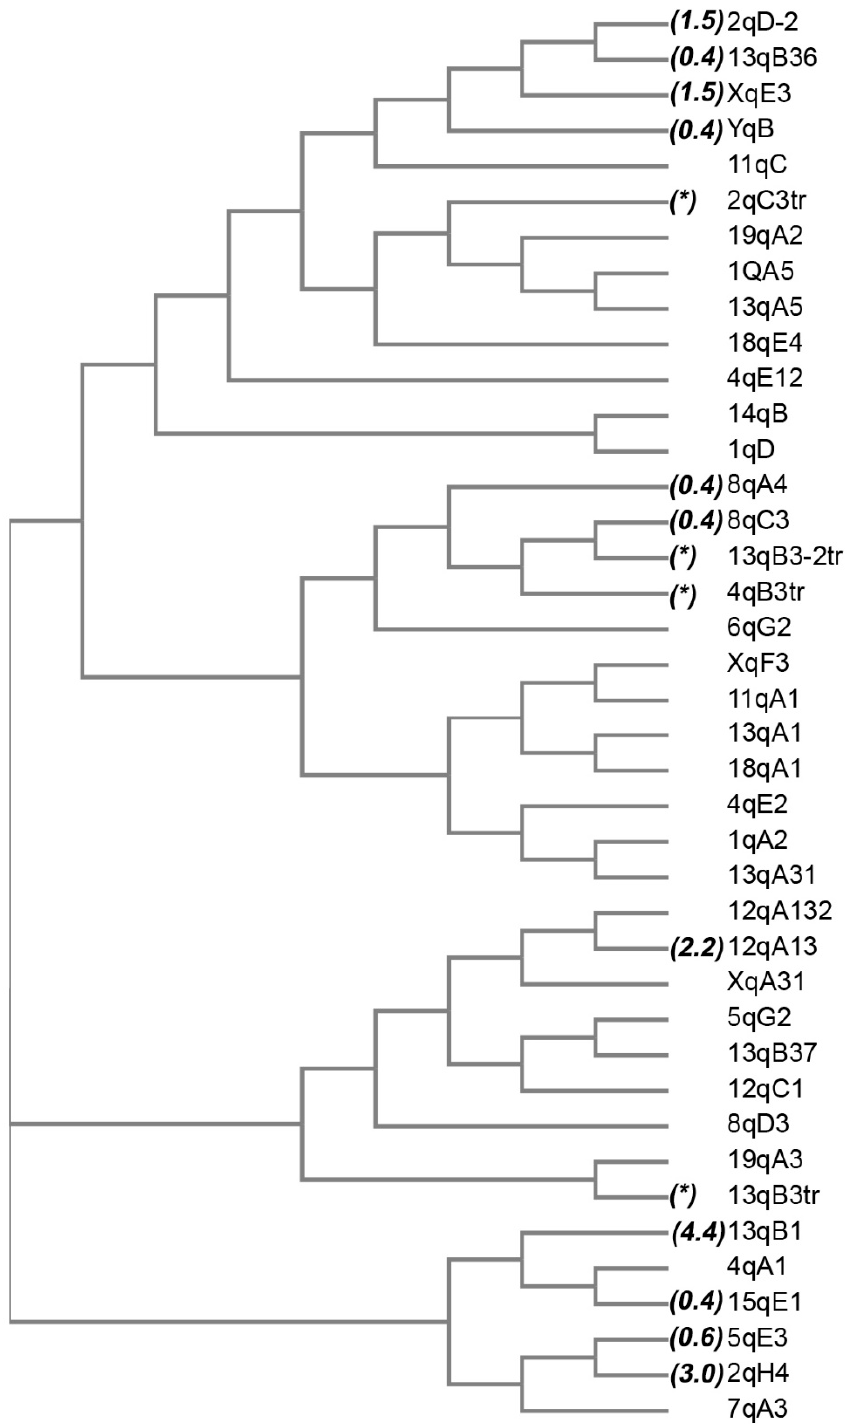
Figure 3. Evolutionary relationships of SEV-VL30s. The evolutionary history was inferred using the Neighbour-Joining method. The optimal tree is shown. The evolutionary distances were computed using the Maximum Composite Likelihood method and are in the units of the number of base substitutions per site. This analysis involved 40 nucleotide sequences. All ambiguous positions were removed for each sequence pair (pairwise deletion option). There were a total of 1130 positions in the final dataset. Numbers in parentheses denote integration time, while asterisk denotes truncated elements in which integration time cannot be calculated.